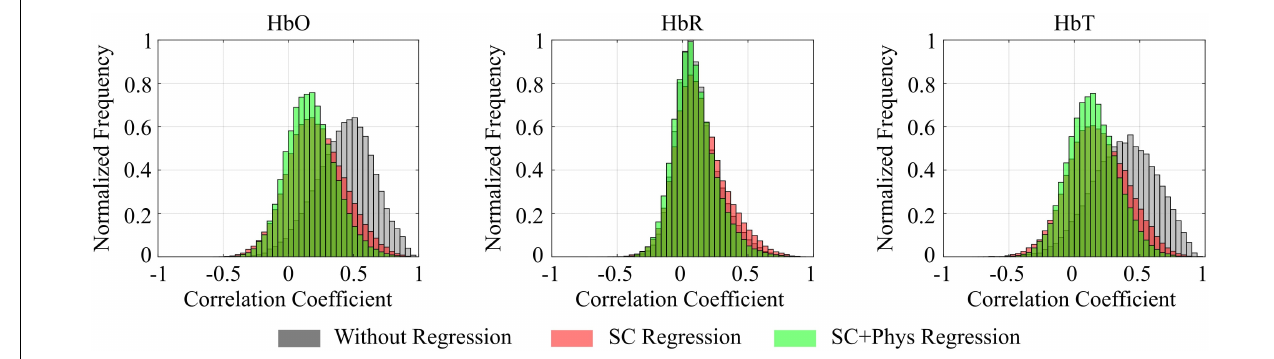
FIGURE 2 | Combined correlation distributions for all participants calculated for oxy-hemoglobin (HbO), deoxy-hemoglobin (HbR), and total hemoglobin (HbT) concentration time series for different preprocessing approaches: before any regression is performed (gray), after regressing only the short channels (SC, red), and after regressing the short channels and systemic physiology (SC+Phys, green). Extracerebral regression has a large impact on the removal of spurious